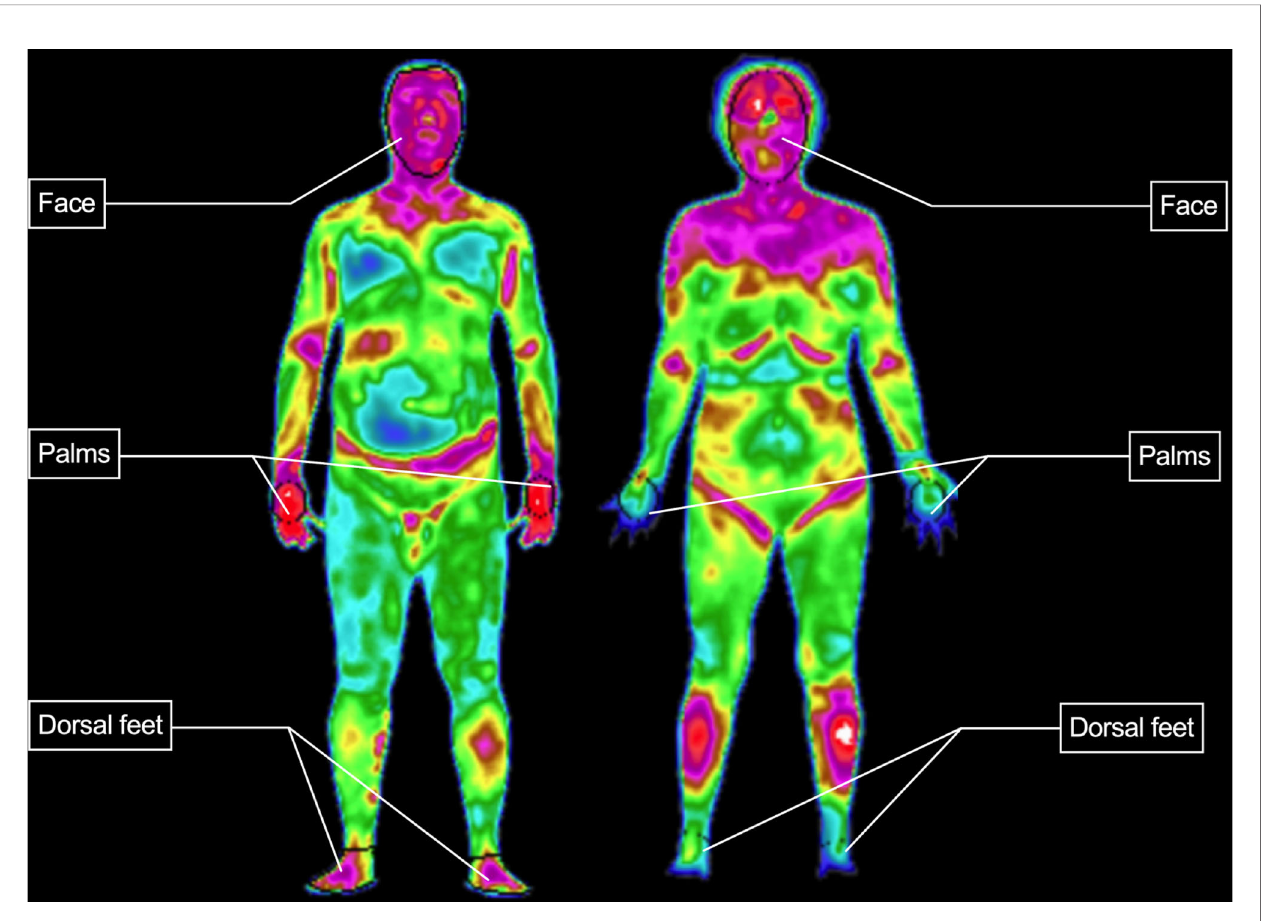
FIGURE 1 | Delimitation of